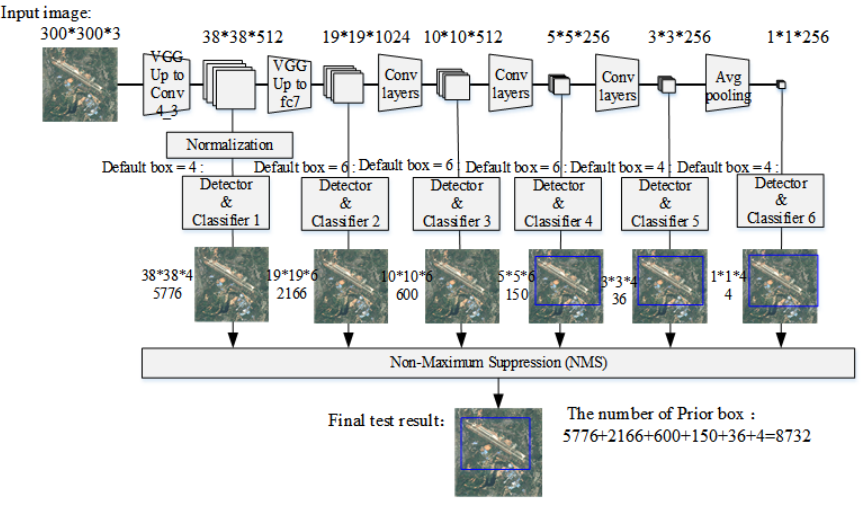
Figure 3. Multi-scale detection in the network.